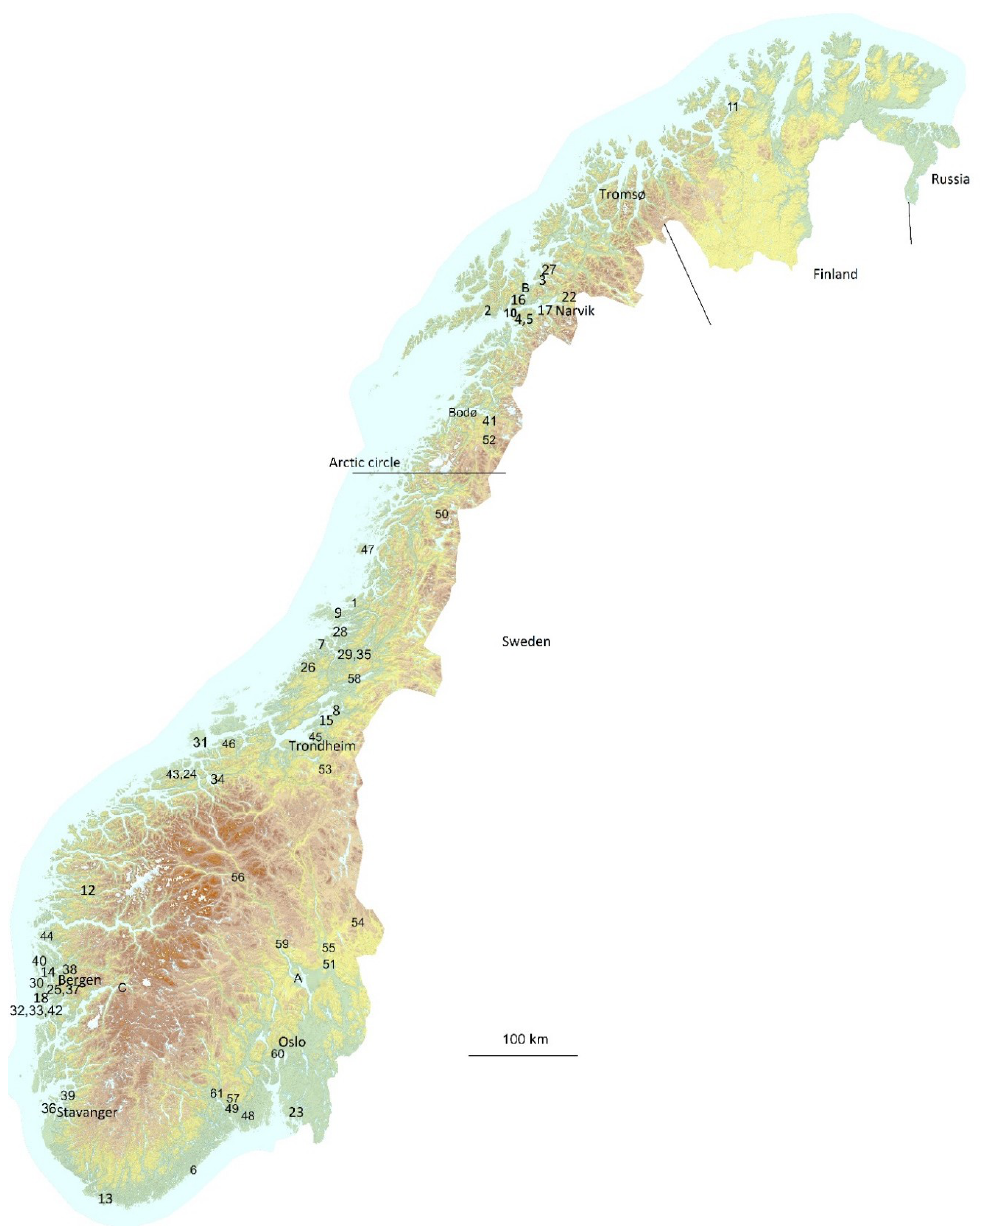
Figure 1. A map of Norway showing the location of the 61 bridges studied. Corrosivity was measured on bridges A, B, C, 14 and